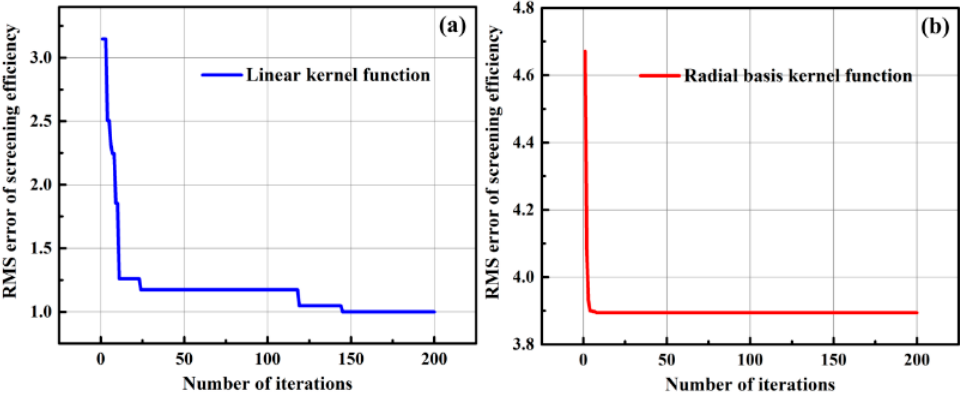
Figure 10. Iterative process of screening efficiency under two kernel functions: ( a ) liner kernel function, and ( b ) radial basis kernel function.